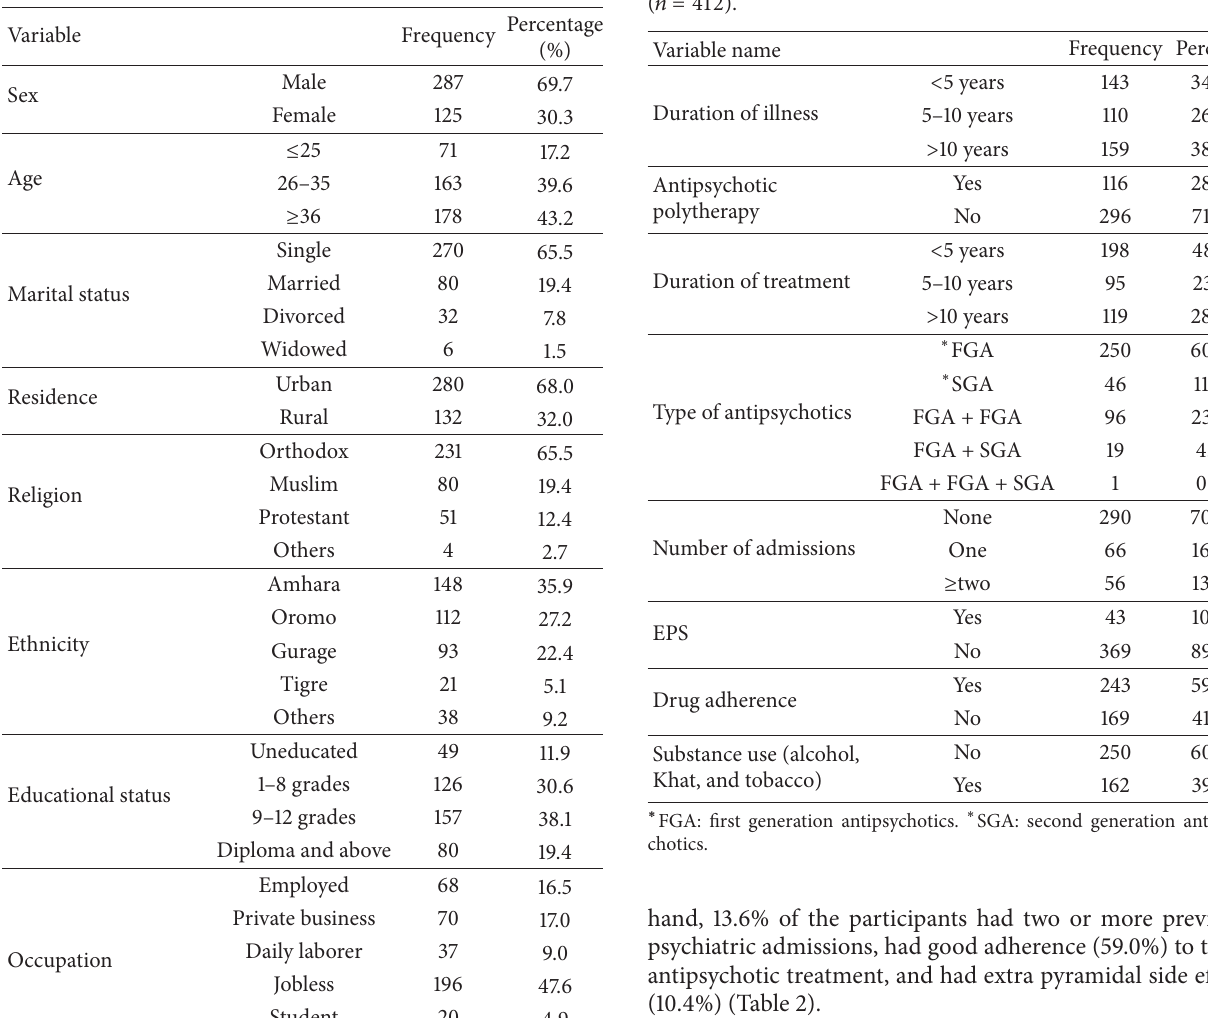
Table 1: Distribution of sociodemographic characteristics of schizophrenia outpatients attending AMSH, June 2014.